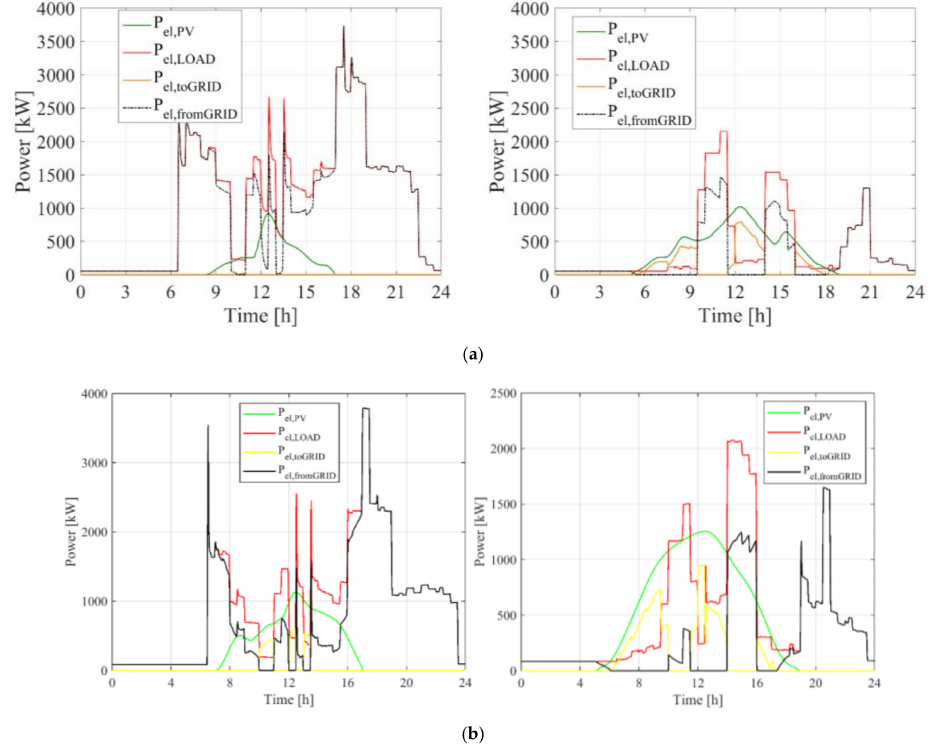
Figure 7. Dynamic results on a representative winter day (left) and a representative summer day (right) of the proposed system 3 (PS3) for the districts located in ( a ) Naples and ( b )